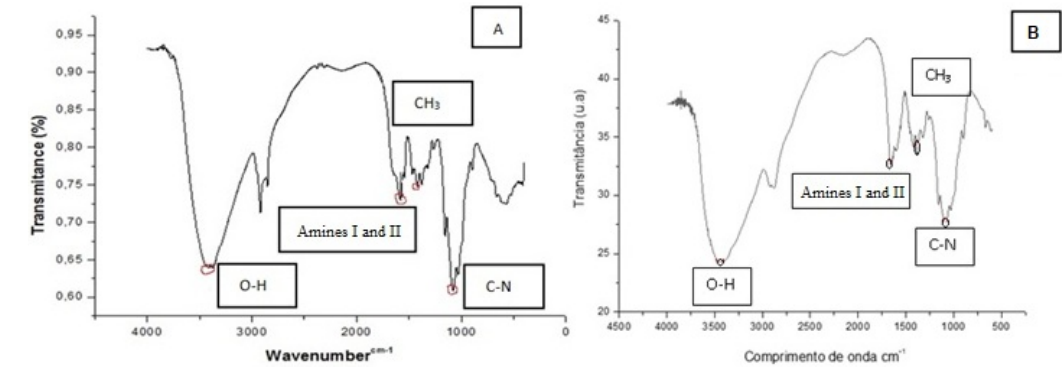
Figure 3. Infrared absorption spectra ( A ) Chitosan produced by microbiological Cunninghamella elegans grown on sucrose, asparagine and corn steep liquor medium (C:N; 2:6) and ( B ) Commercial chitosan.